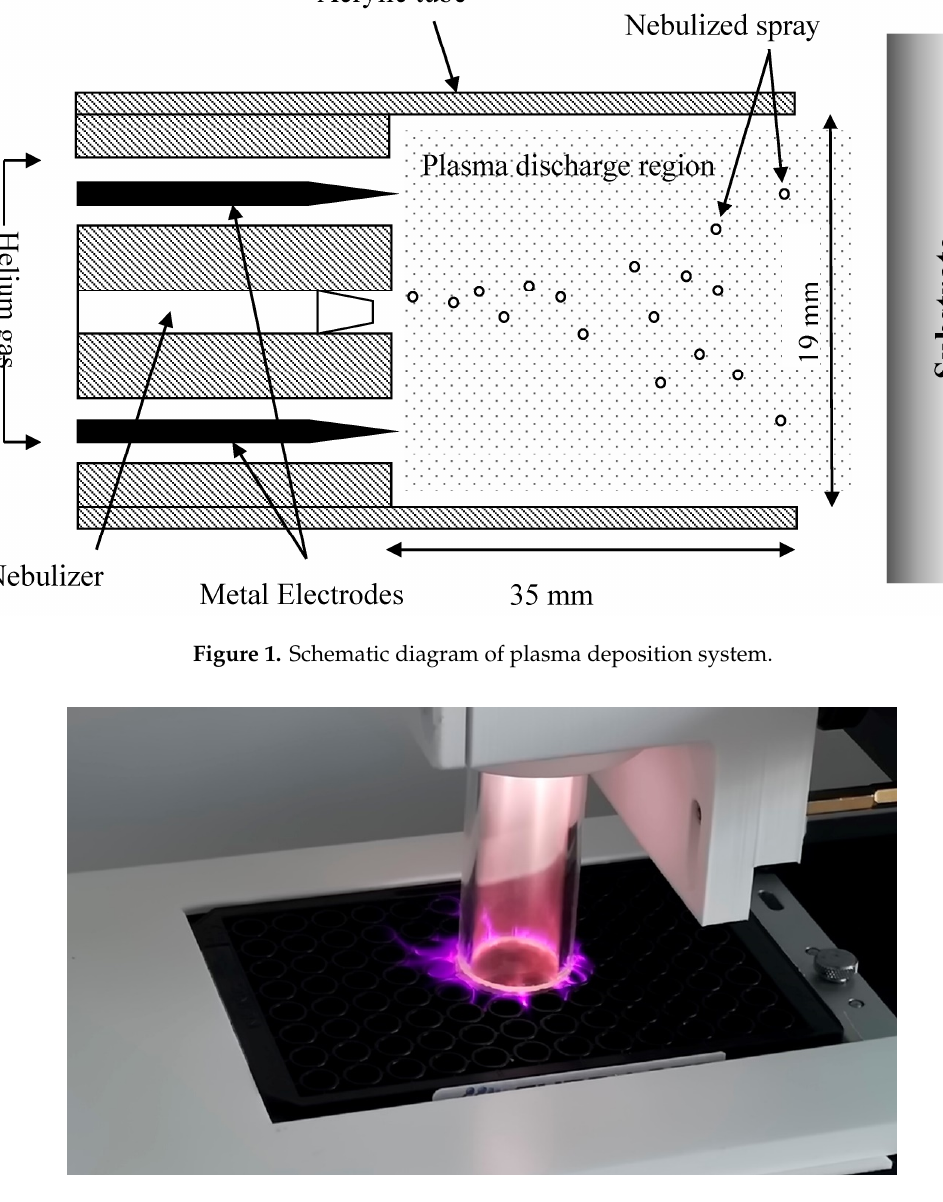
Figure 2. Plasma deposition system treating a 96-well microplate.